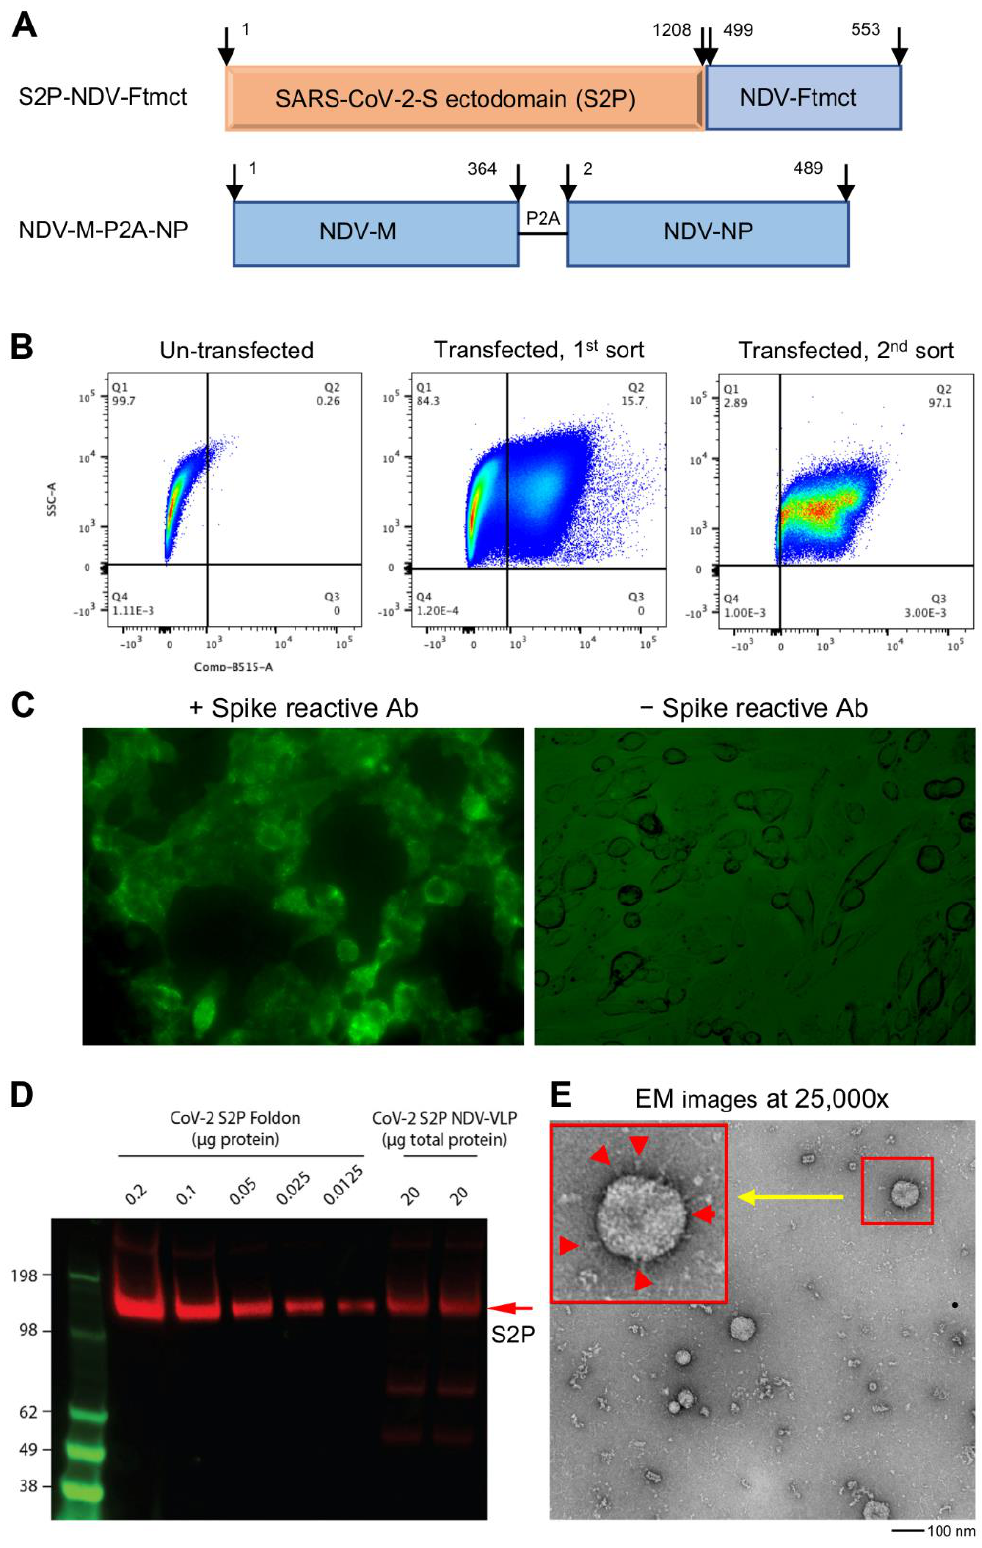
Figure 1. Generation and characterization of SARS-CoV-2 spike membrane-anchored on Newcastle disease virus-like particle (S2P-NDVLP). ( A ) Schematic construction of S2P-NDVLP-expression plasmids. The top linear diagram shows a S2P-NDV-Ftmct chimeric construct, with the SARS-CoV-2 prefusion-stabilized spike glycoprotein ectodomain (S2P, red) fusing with the NDV fusion protein transmembrane and cytoplasmic tail domain (Ftmct, blue). The bottom linear diagram shows the coexpression construct, the full-length NDV matrix protein (NDV-M, blue) and nucleoprotein (NDV-NP,